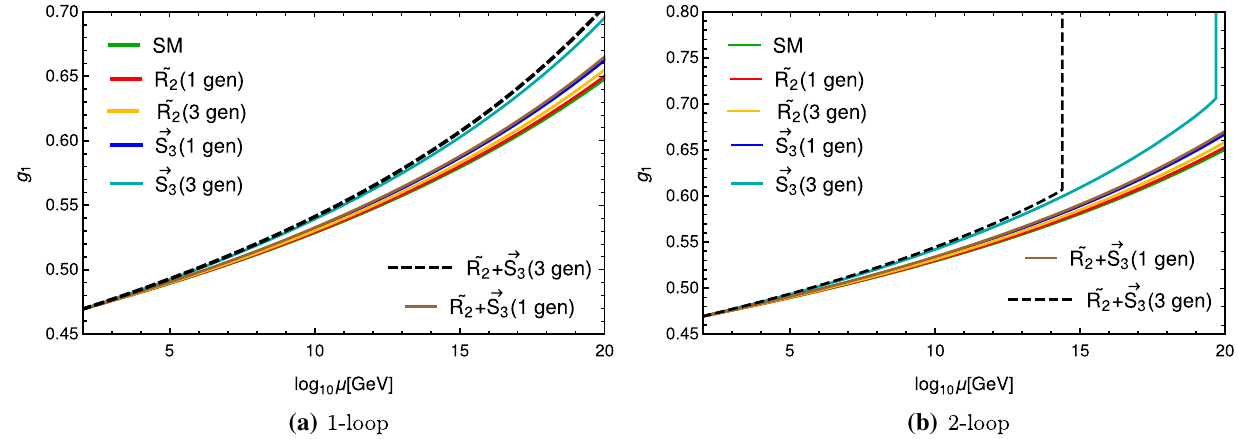
lines, respectively; the brown and dashed black curves illustrate the SM extension with one and three generations of both (cid:2) R 2 and S 3 , respec- tively. The initial values for SM parameters are listed in Table 1 along with Y φ = 0 .